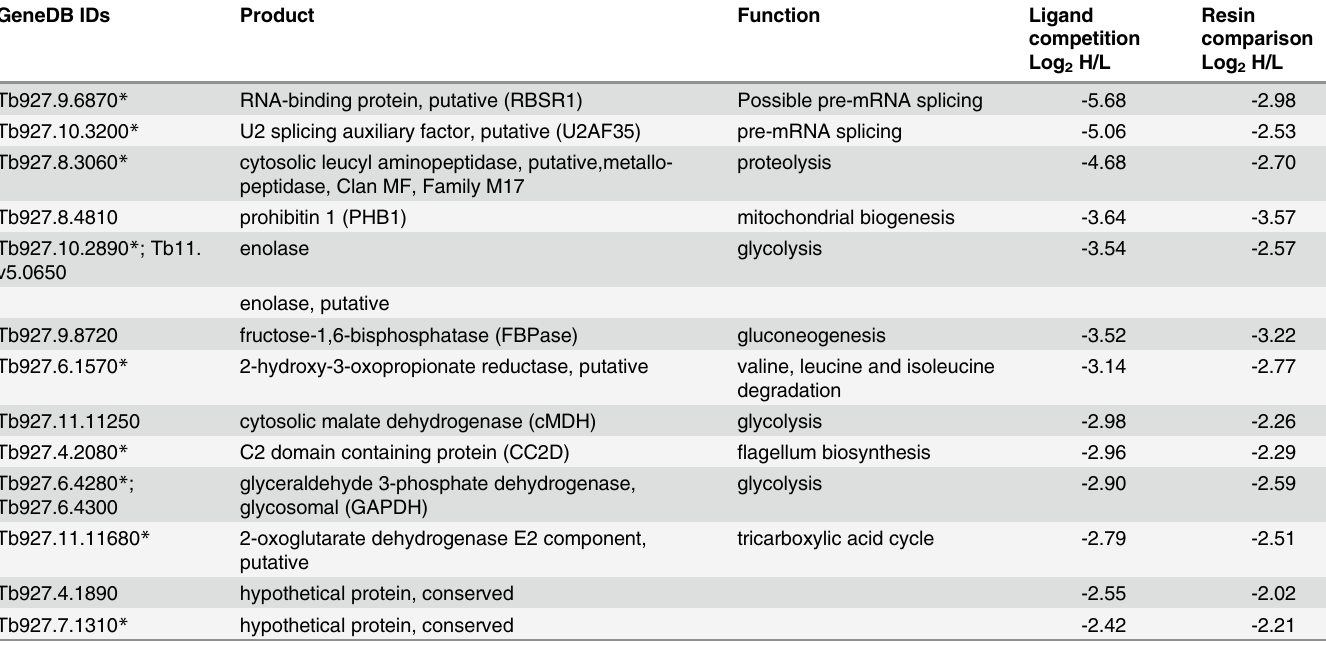
Table 1. Specific binding partners of the Oxaborole-Resin revealed by proteomic